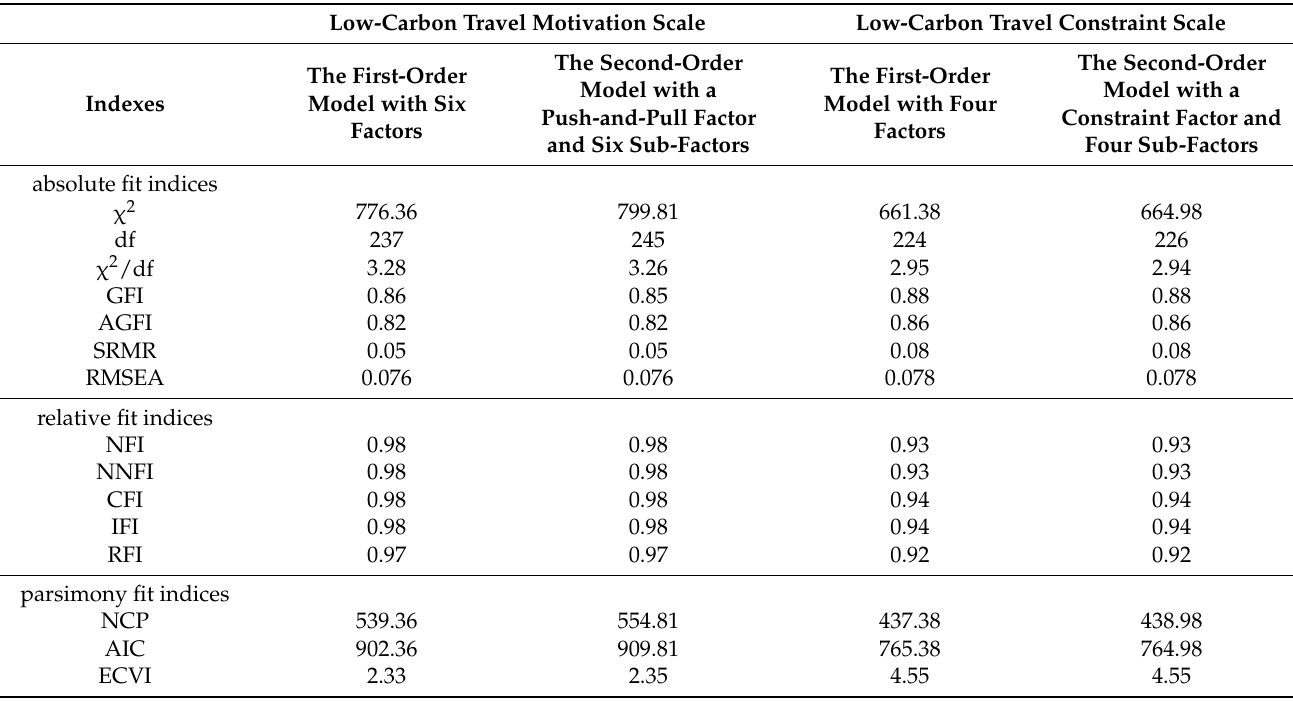
Table 8. Comparison of competitive